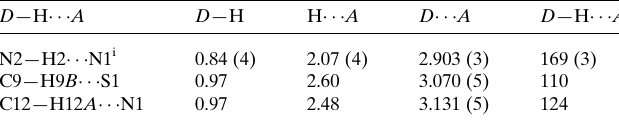
Table 1 Hydrogen-bond geometry (A˚ , (cid:2) ).